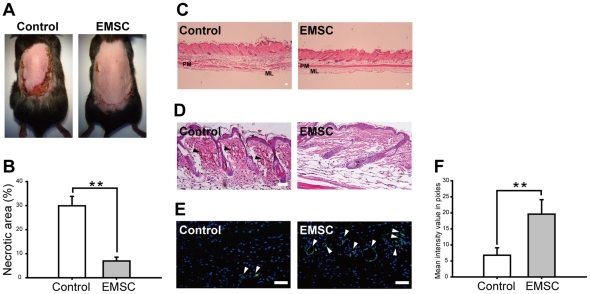
Prevention of skin flap necrosis in mice by EMSCs injection.(A) Ischemic flap showed necrosis in the control mice and near complete healing in the EMSCs (at the fifth passage) injected mice after 6 days of surgery. (B) Percentage of necrosis was quantified by planimetry. Percentage of necrotic area is significantly larger in the control group than in the EMSCs injected group (n = 4). (C) The skin structure was evaluated by H&E staining. Skin thickness is decreased and mucinous layer is preserved in the EMSCs injected group as compared to the control group. (D) In higher magnification, extra vascular erythrocytes and hemorrhage (arrowhead) can be observed in the control group. (E) Immunostaining of von Willebrand factor (vWF) of skin flap, and (F) its quantification showed significantly more vWF expressed cells (arrowhead) in the EMSCs injected group than the control group. **represents P<0.01. Scale bars represent 100 µm. Data are presented as mean ± s.d. and analyzed with Student's t-test. PM: platysma muscle; ML: mucinous layer; Control: complete medium injection-group; EMSC: EMSCs-injection group.